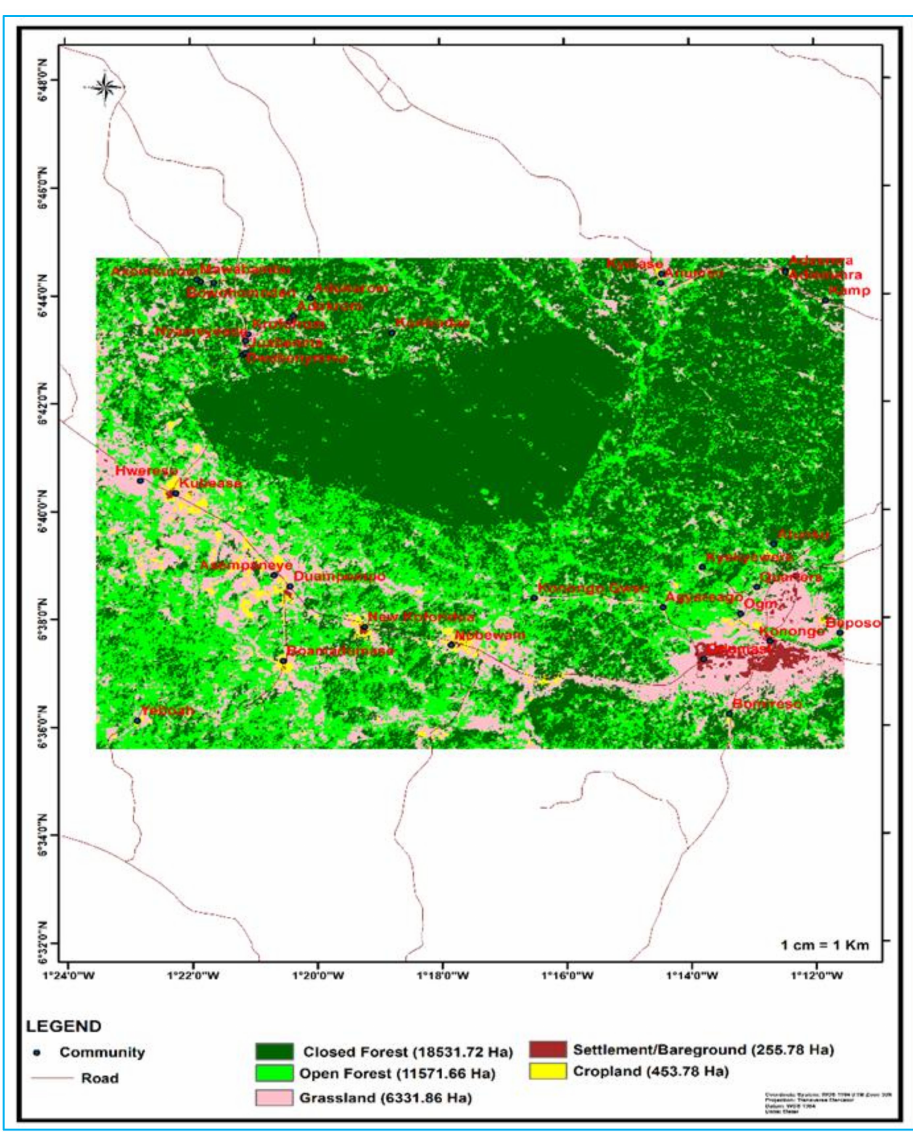
Figure 4. Landsat image of Bobiri forest reserve in 1986. Figure 5 shows the Landsat image for 2003. Grassland increased to 29.4% with a massive reduction in the closed forest cover to 33.3%. The northeastern part of the reserve was gradually turned into open forest. The northern part was still made up of closed forest. Although crop land shot up marginally, farming was still practiced on a small scale by indigenes of the rural